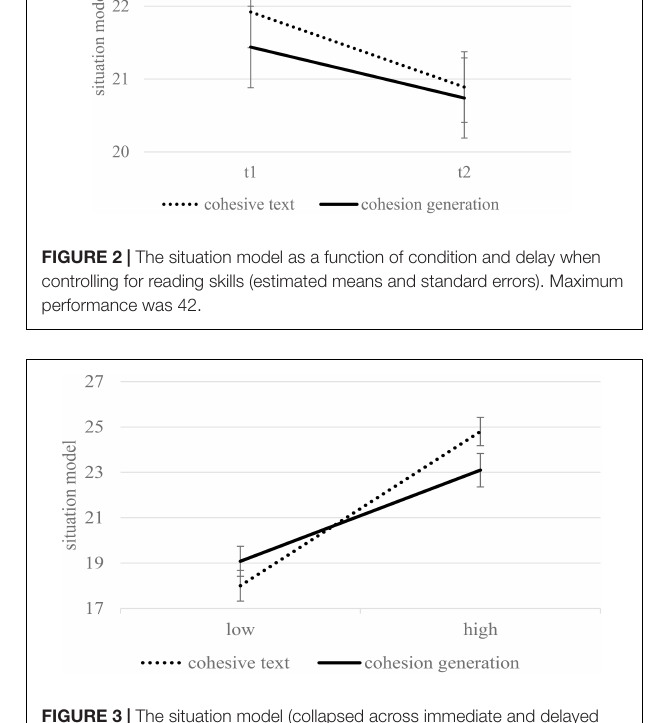
FIGURE 3 | The situation model (collapsed across immediate and delayed testing) as a function of condition and the level of reading skills (estimated means and standard errors for –1 SD and +1 SD). Maximum performance was